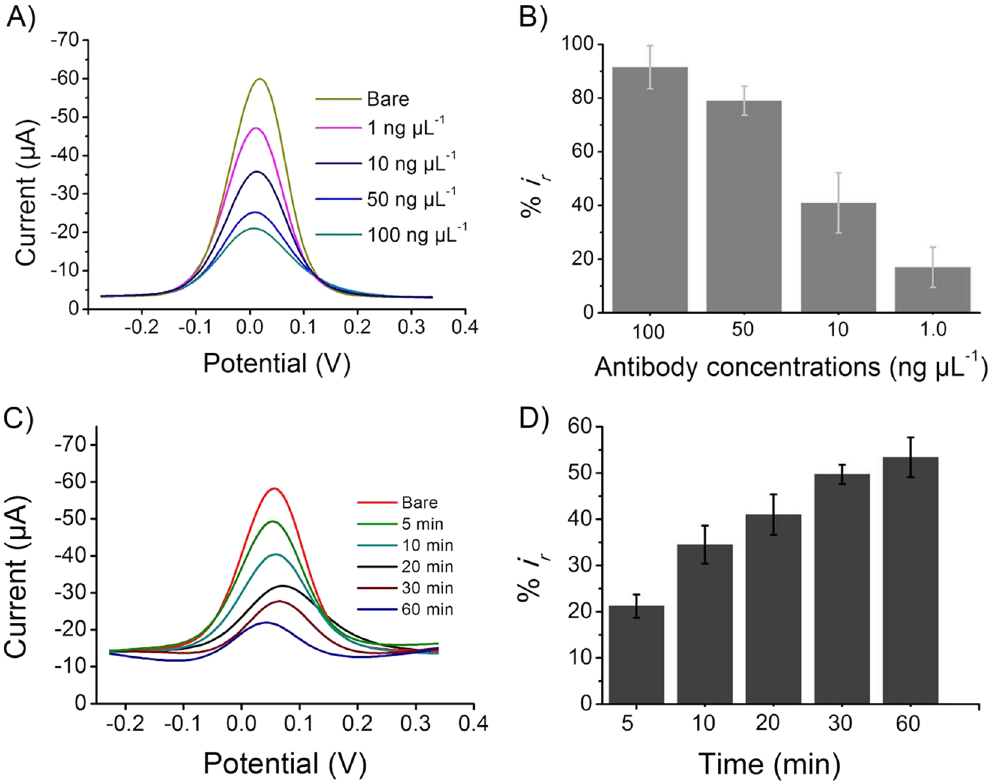
Figure 2. Optimization of the experimental conditions. Typical differential pulse voltammetry signals ( A , C ) and corresponding relative current changes ( B , D ) after the adsorption of FAM134B antibody on the extravidin- modified screen-printed electrode. ( A ) the designated concentrations (1–100 ng µ L − 1 ) of FAM134B antibody was immobilized for 20 min. ( C ) 10 ng µ L − 1 of FAM134B antibody was immobilized for the designated times (5–60 min). Each data point represents the average of the three separate trials ( n = 3) and error bars represents the standard deviation of measurements within